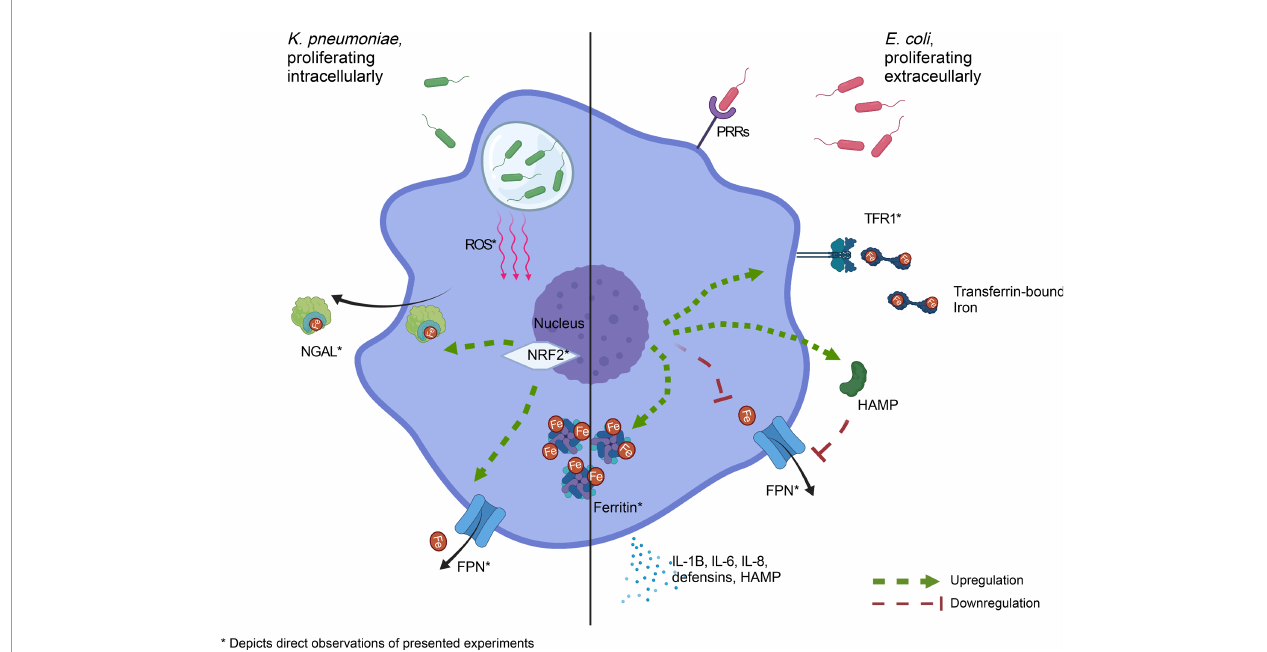
FIGURE 5 | Pathogen-speci fi c adaption of cellular iron homeostasis in AECII. Left panel: K. pneumoniae , capable of proliferating intracellularly, elicits an iron-export phenotype, likely mediated by oxidative stress. Right panel: E. coli , which proliferates predominantly in the extracellular space, induces an iron retention phenotype in infected AECII. * denotes direct experimental observations AECII, type-2 alveolar epithelial cell; ROS, reactive oxygen species; NGAL, neutrophil gelatinase- associated lipocalin 2; PRR, pattern recognition receptor; TFR1, transferrin receptor-1; FPN, ferroportin; NRF2, NF-E2-related factor 2; Created with